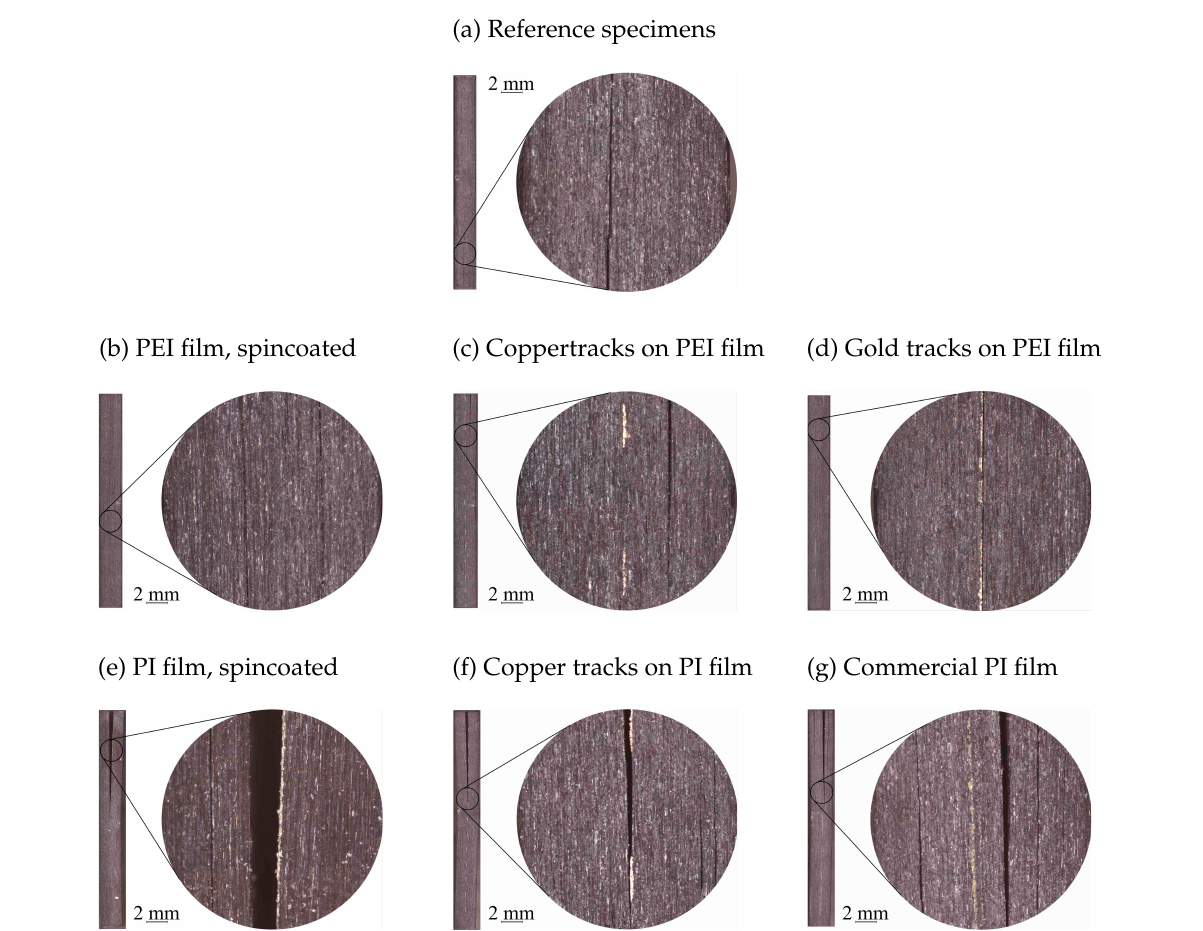
Figure 11. Side view of fractured ILS specimens: ( a ) Reference specimens. ( b ) PEI film, spin coated, without sensor pattern. ( c ) PEI film, spin coated, with copper tracks @ 90°. ( d ) PEI film, spin coated, with thin gold tracks @ 0°. ( e ) PI film, spin coated, without sensor pattern. ( f ) PI film, spin coated, with copper tracks @ 90°. ( g ) Commerial PI film